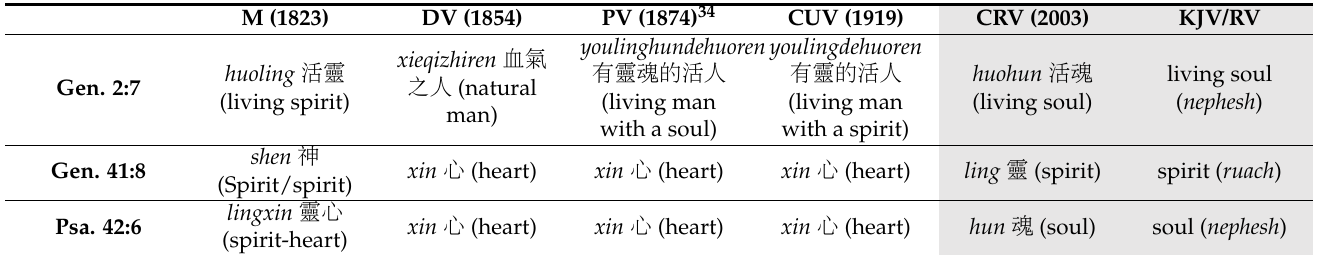
Table 3. The translation of ruach (spirit) and nephesh (soul) in the Old Testament. M (1823)